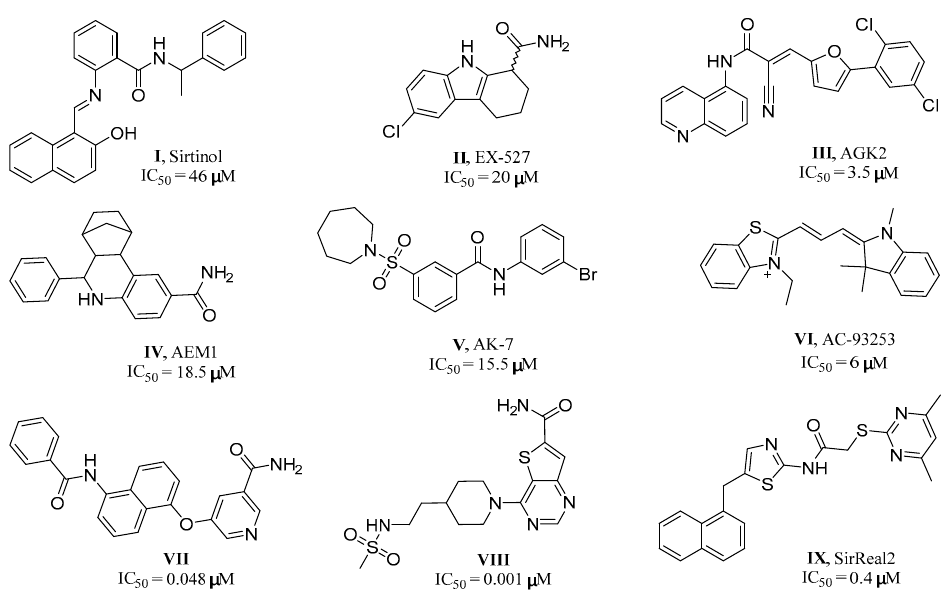
Figure 1. Chemical structures and inhibition potencies of selected examples SIRT2 inhibitors.